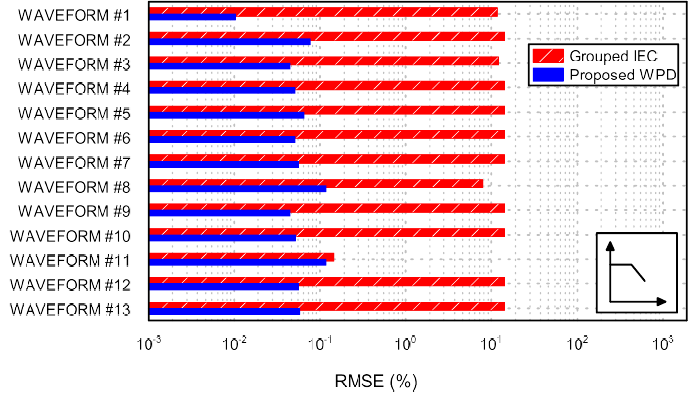
Figure 8. RMSE for each assessed waveform under fluctuating conditions, for grouped IEC and WPD, in the case of linear modulation (motor-start type).